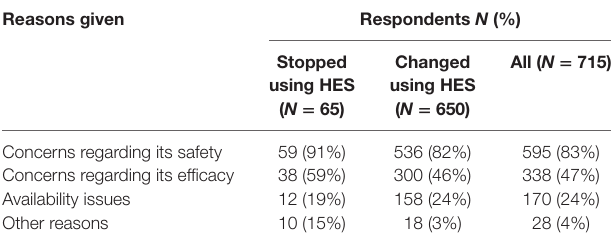
TaBle 3 | Constant rate infusion dose of synthetic colloids used by survey respondents. ml/kg/h